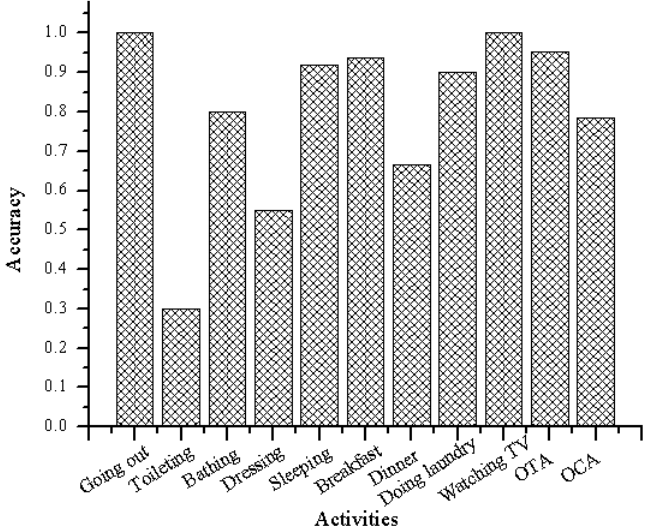
Figure 9. Algorithm’s (trained using the web data) accuracies per activity. The rightmost two bars compare the overall timeslice accuracy (OTA) and the overall class accuracy (OCA).